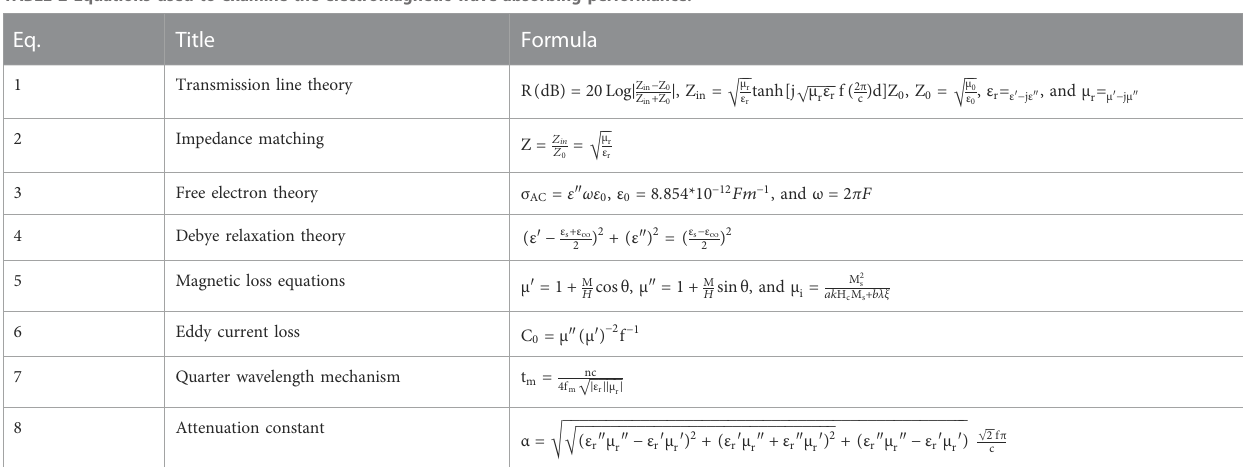
threelayers: adielectricspacer, metallicstructures,and ametallicmirror, which can be used to form MMAs with various designs (Duan et al.,